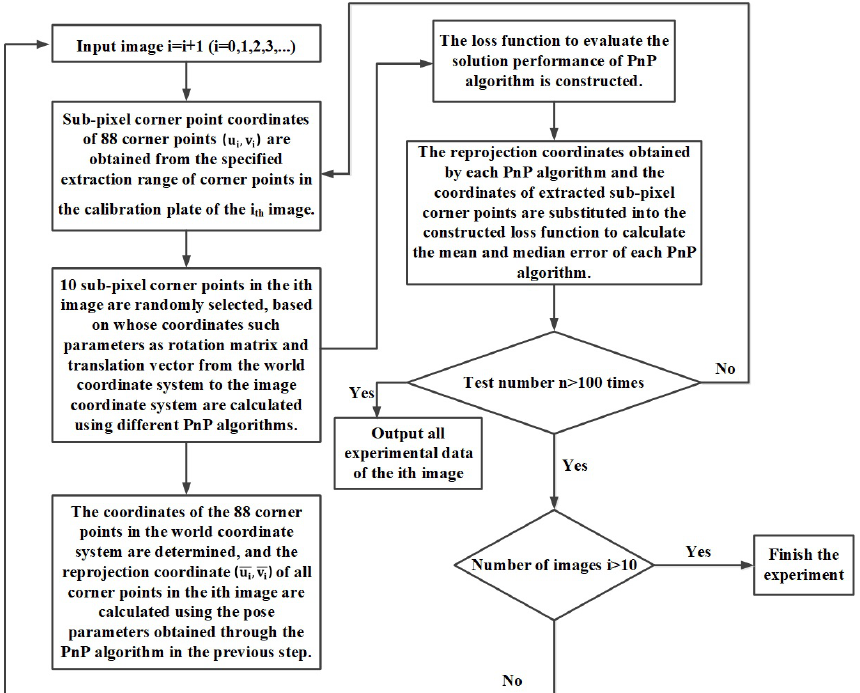
Figure 11. Flow chart of physical objects reprojection experiment.